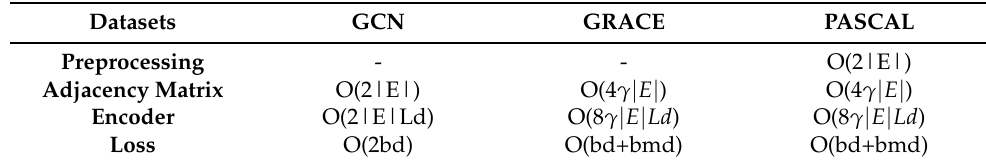
Table 7. Analysis of time complexity.